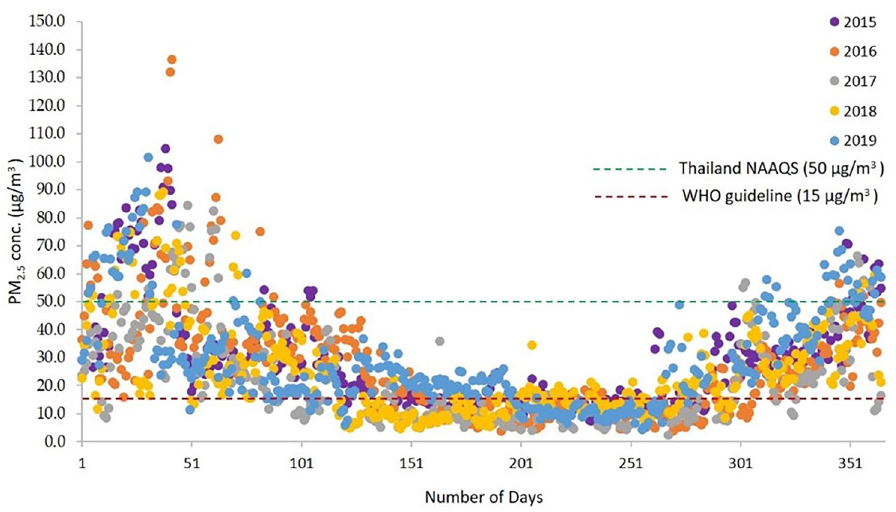
Figure 2. The pattern of PM 2.5 concentration in Ratchaburi province during